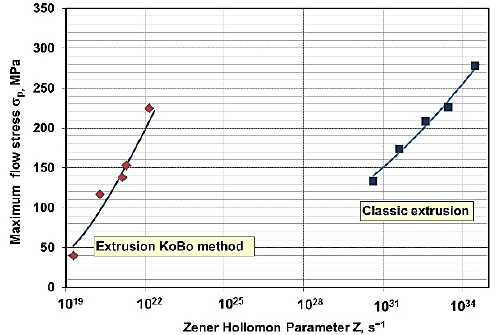
Figure 7. Comparison of the maximum flow stress σ p max — Zener – Hollomon parameter Z dependence for WE43 alloy after concurrent and combined extrusion; markers — experimental data, solid line of calculation.